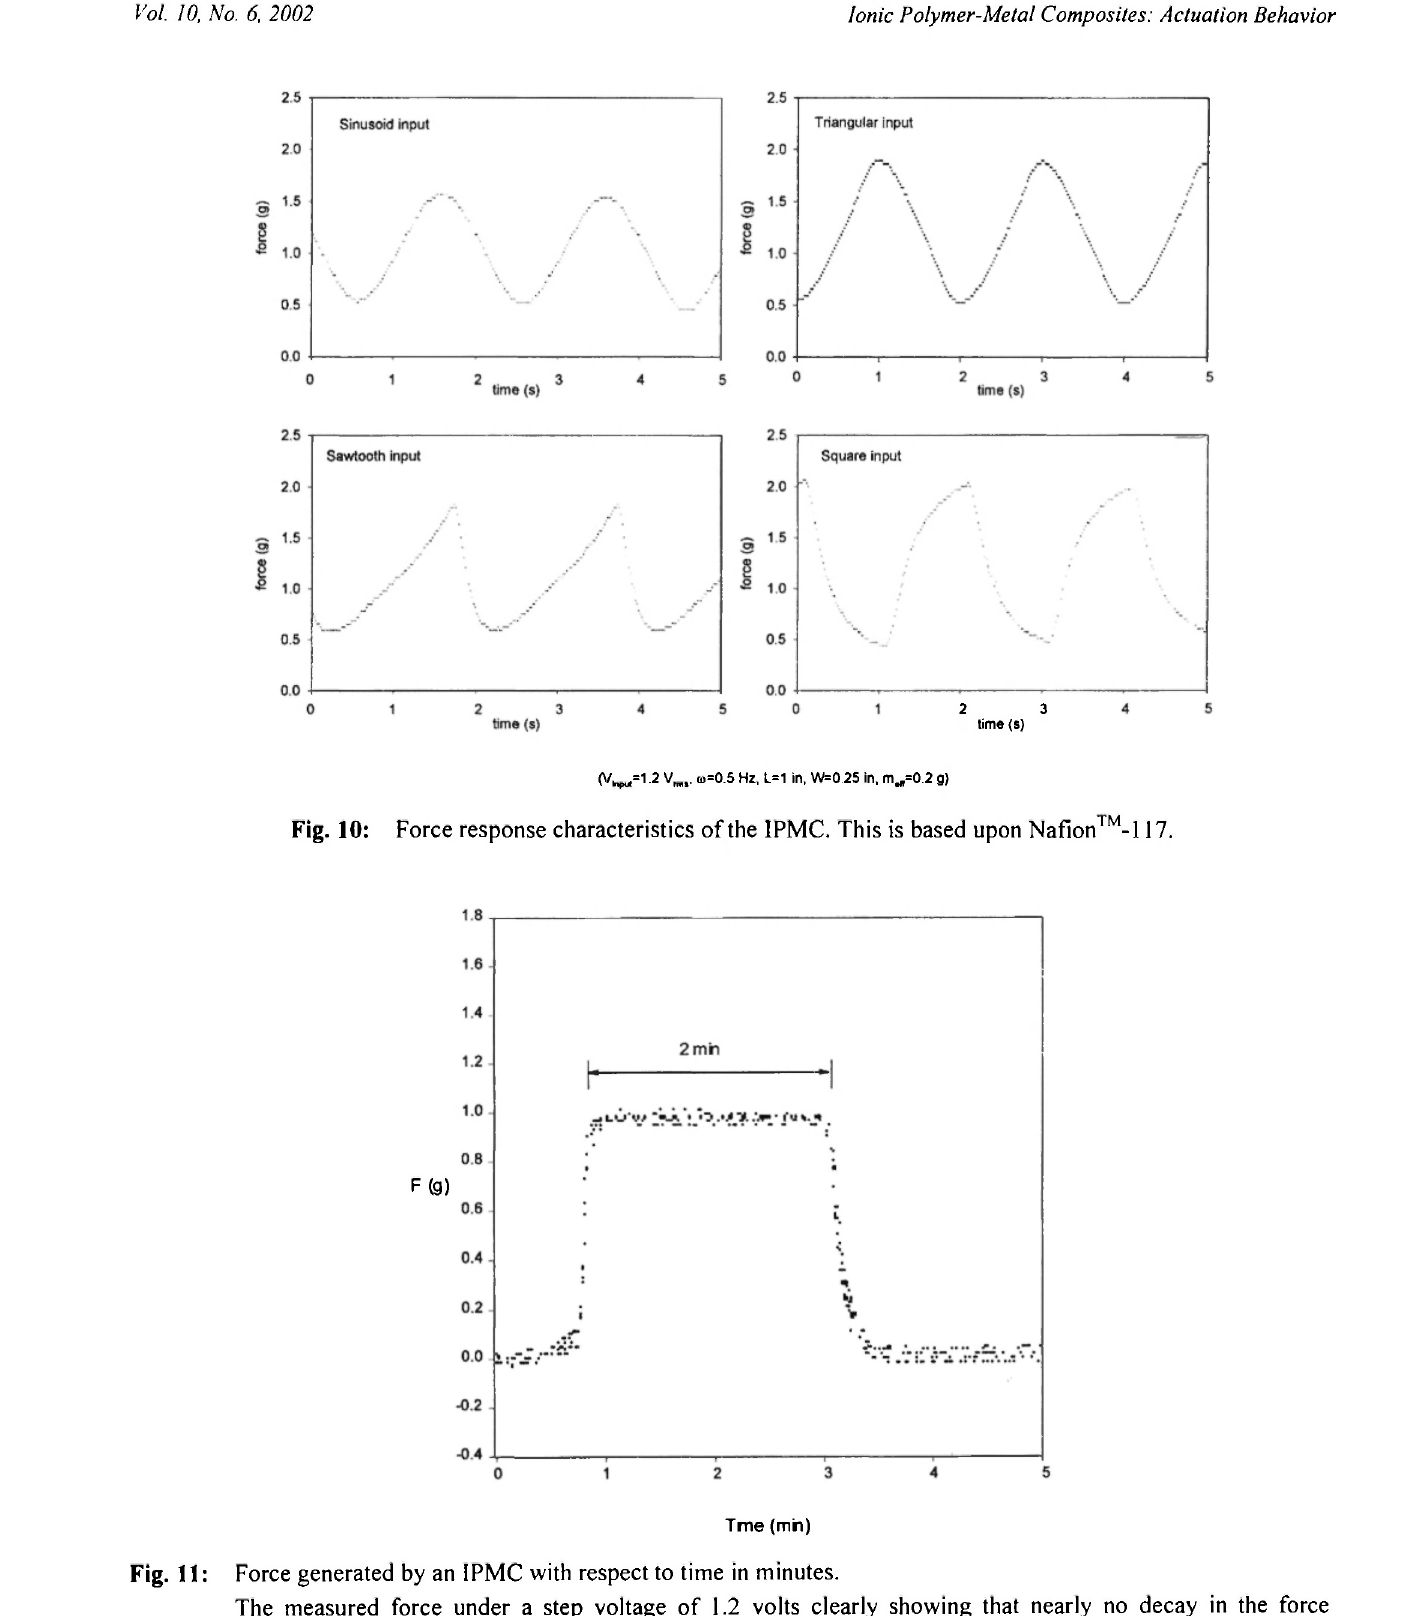
Trne (mh) Fig. 11 : Force generated by an IPMC with respect to time in minutes. The measured force under a step voltage of 1.2 volts clearly showing that nearly no decay in the force generated over a period of 2 minutes. The dimension of the IPMC sample is % χ V* inch. In this case, the surface electrode is effectively made to block water